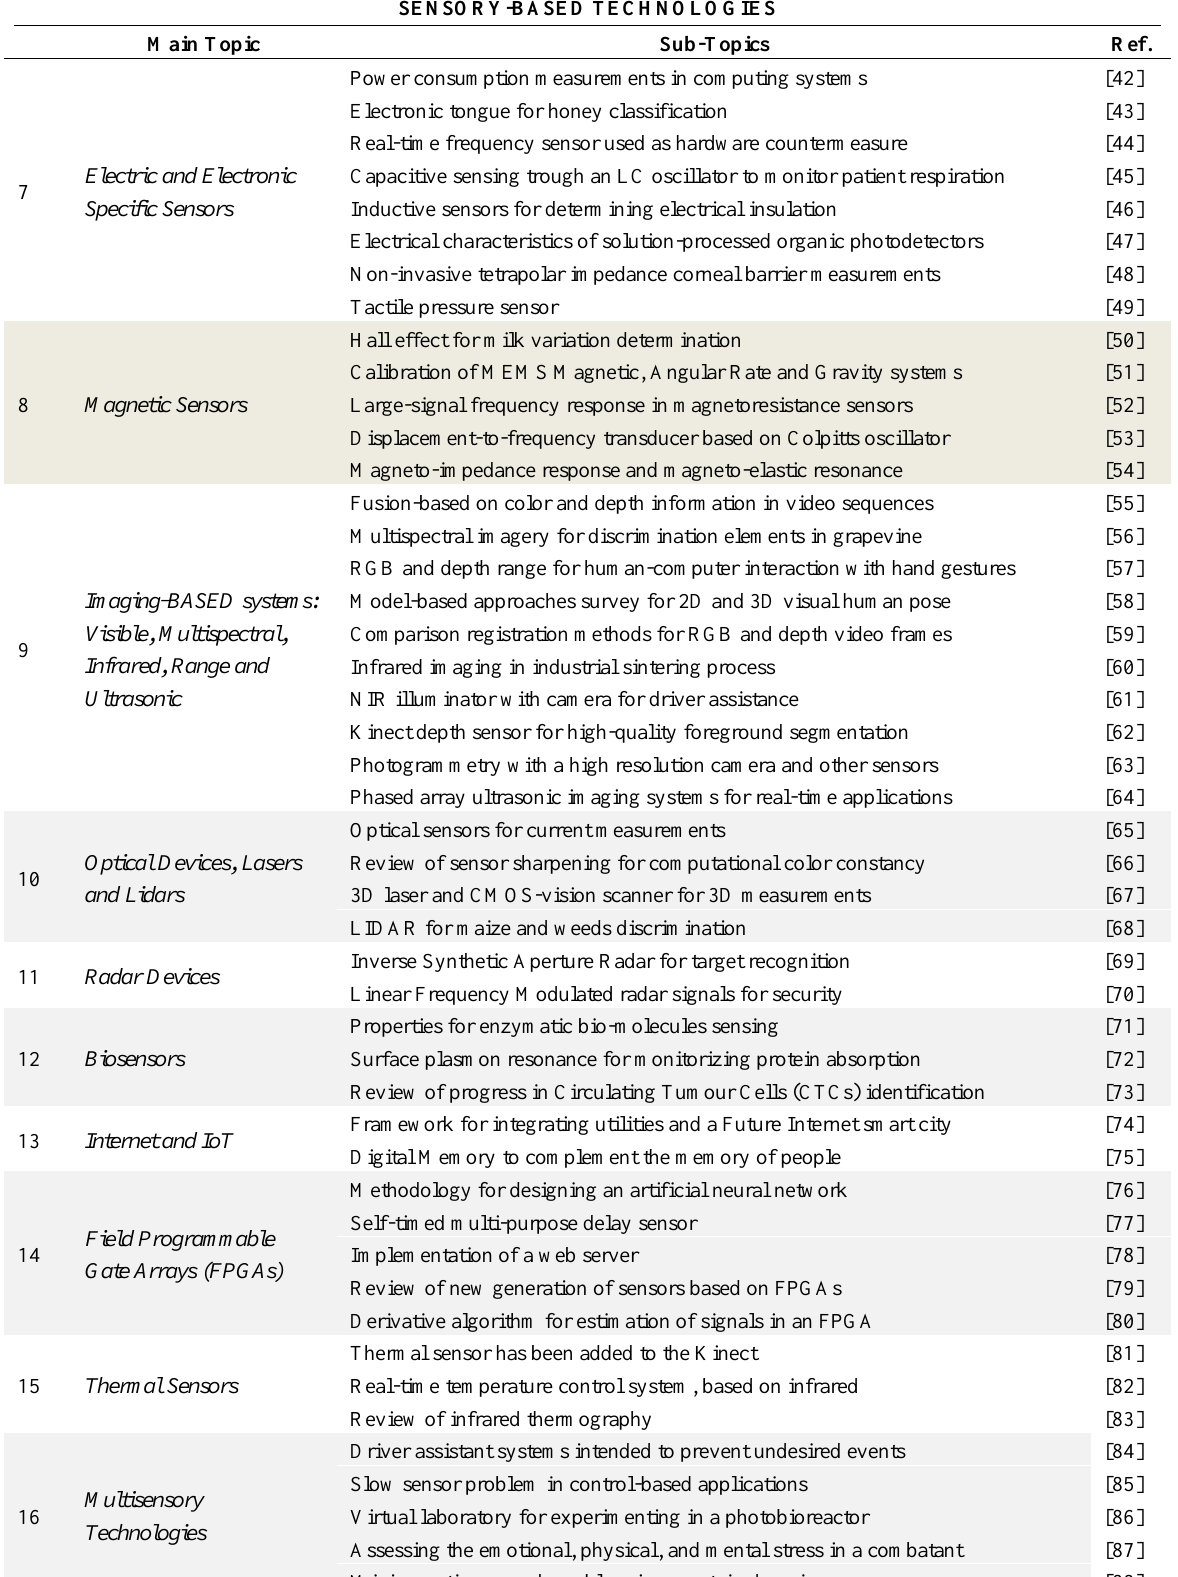
Table 2. Sensory-based technologies: main topics and subtopics covered by the special